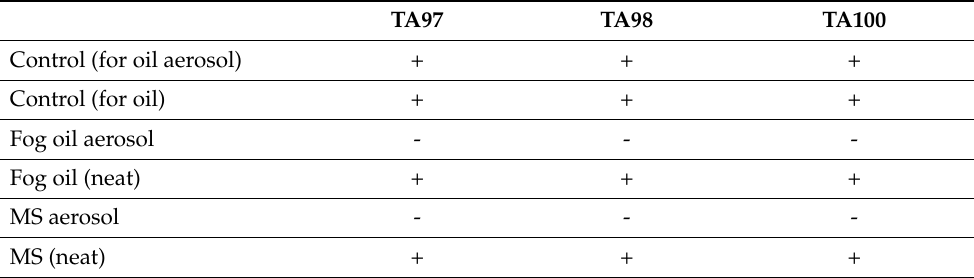
Table 8. Results of standard test for surface disinfectants. TA97 TA98 TA100 Control (for oil aerosol)